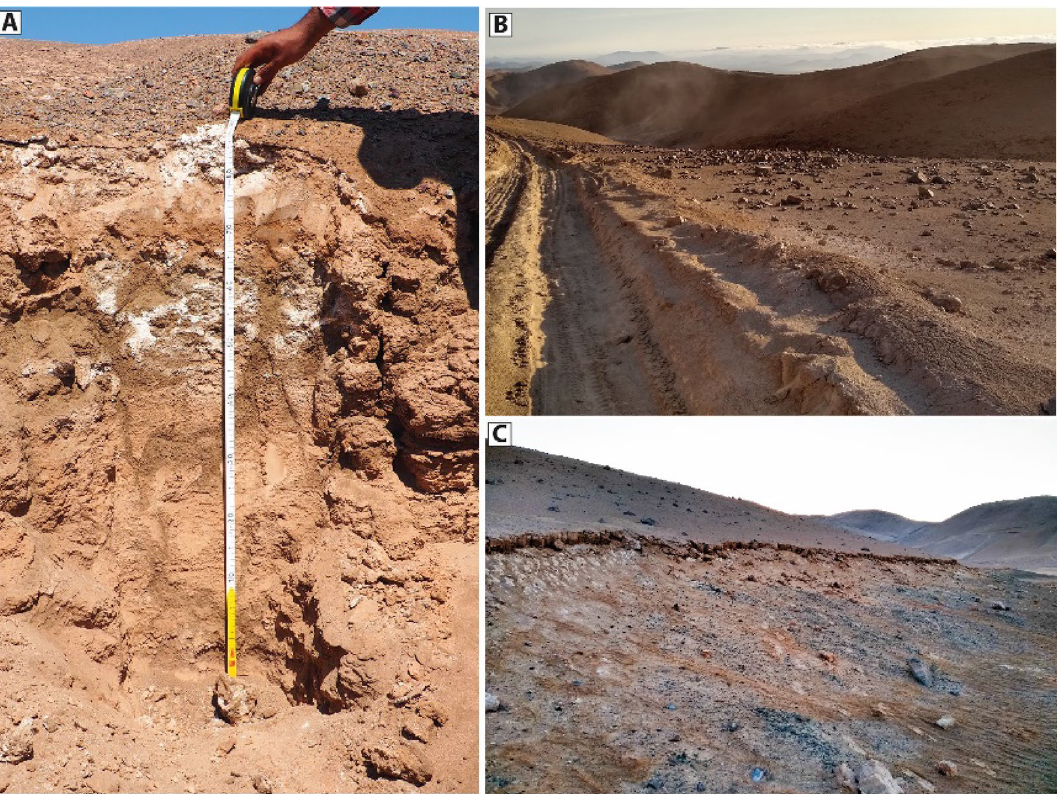
Figure 4. Typical occurrence of the ubiquitous CaSO 4 -rich soil in the study area. ( A ) Soil profile. ( B ) Powdery CaSO 4 surface cover. ( C ) CaSO 4 -crust and subsurface